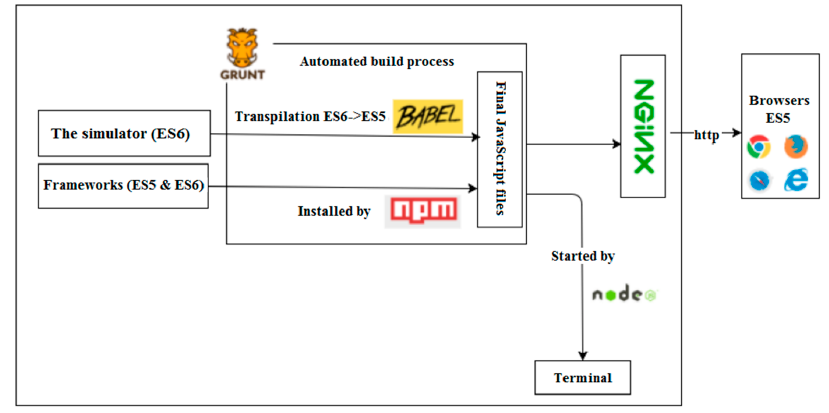
Figure 7. The application structure.